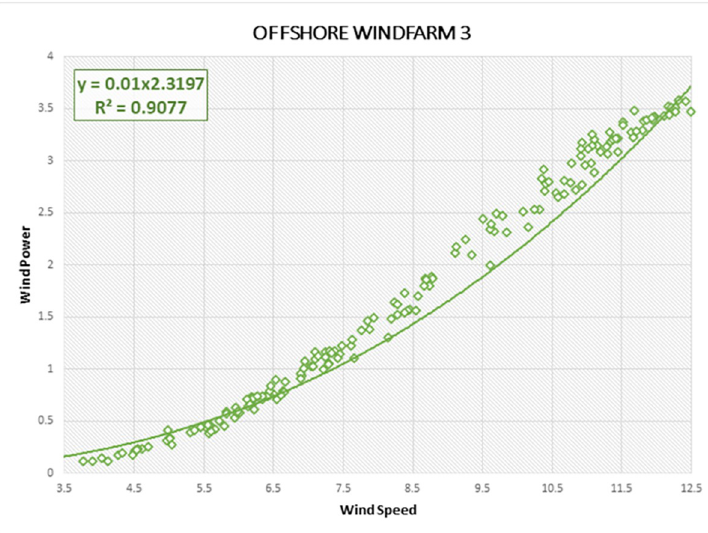
Fig 14. R-Squared correlation and best curve fitting on wind power and wind speed observations of Offshore Windfarm 3 dataset.